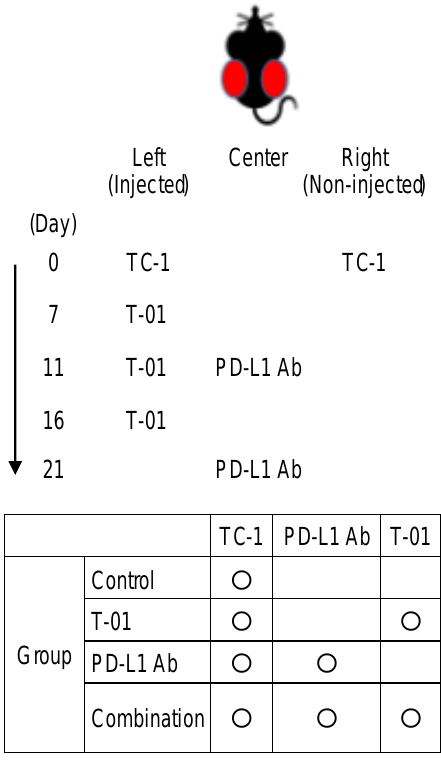
Figure 1. Experimental design of T-01 treatment in combination with PD-L1 inhibition in a murine bilateral subcutaneous TC-1 tumor mode.